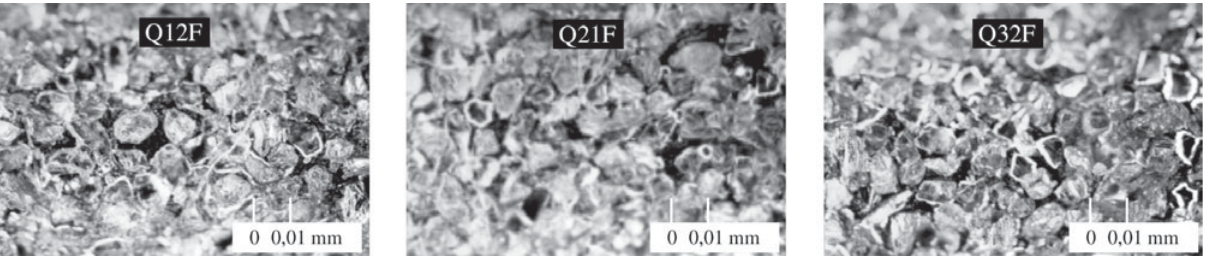
Figura 7. Superfície da ponta usinada após a realização dos ensaios, após uma, duas e três esterilizações por glutaraldeído,